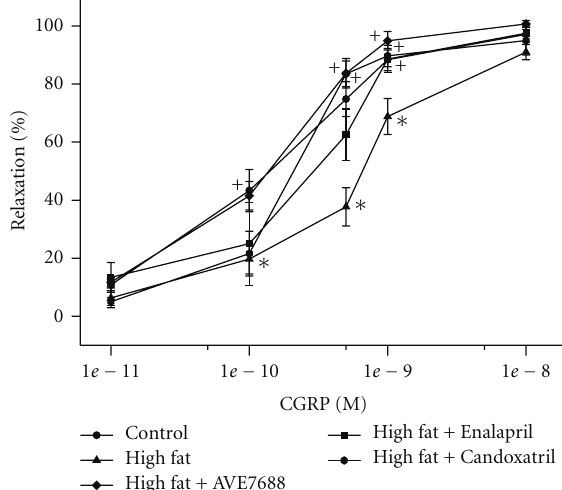
Figure 4: E ff ect of a high-fat diet and treatment with AVE7688 on acetylcholine-mediated vascular relaxation of epineurial arterioles. Rats were fed a standard or high-fat diet with or without AVE7688, Enalapril, or Candoxatril for 24 weeks. Pressurized arterioles (40mm Hg and ranging from 60–100 μ m luminal diameter) were constricted with U46619 (30%–50%) and incremental doses of acetylcholine were added to the bathing solution while recording steady state vessel diameter. Data are presented as the mean of % relaxation ± SEM. For these studies, two vessels were collected from each rat, studied, and the data combined. The number of rats in each group was the same as shown in Table 1. ∗ P < . 05, compared to rats fed the standard diet (control), + P < . 05, compared to rats fed the high-fat diet.